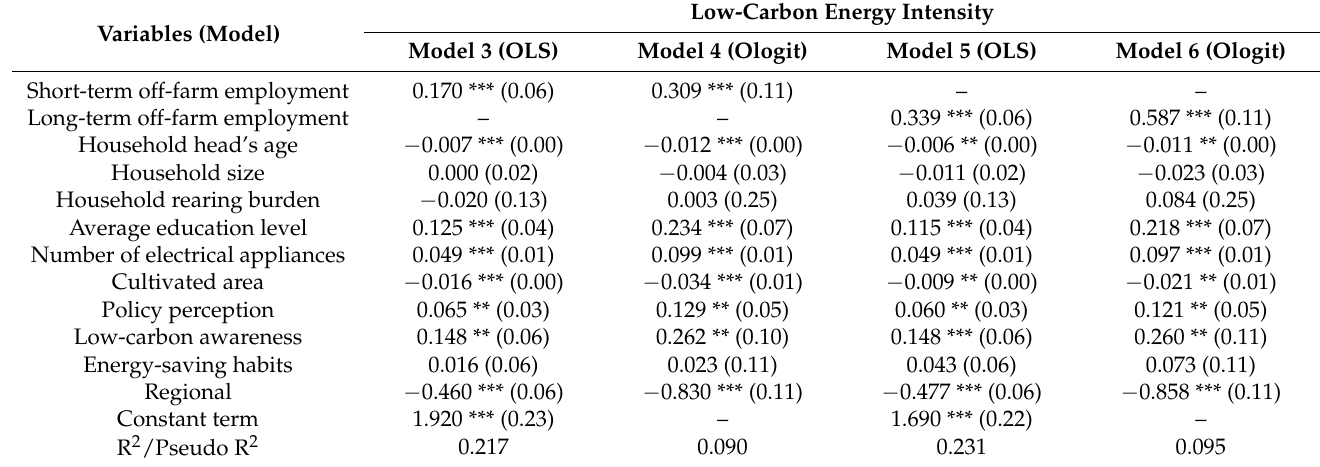
Table 3. Short-term and long-term off-farm employment and farmers’ low-carbon energy intensity (N =